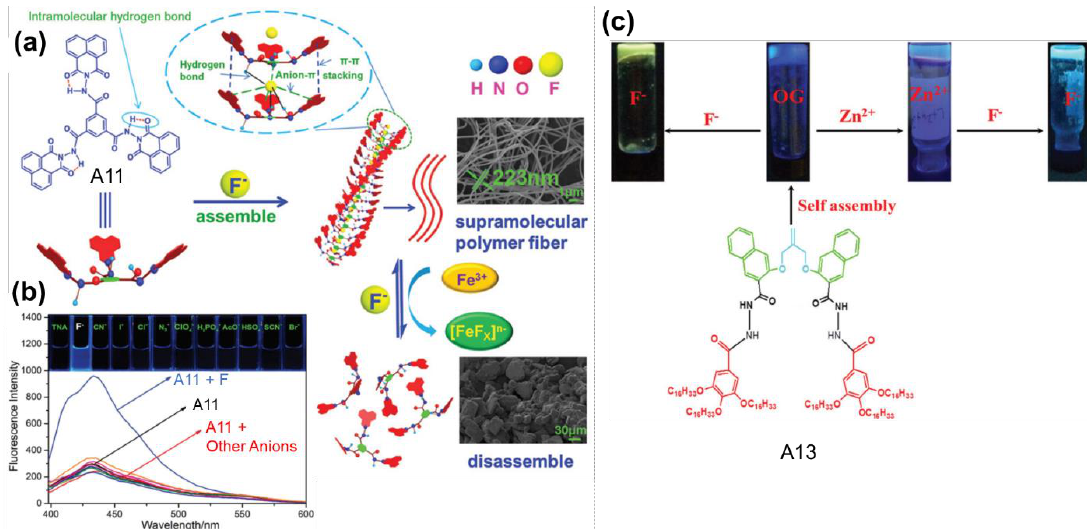
Figure 4. ( a ) Schematic representing the assembly and disassembly of A11 -fluoride supramolecular polymer. ( b ) Emission spectra and photo showing the response of A11 in the presence of fluoride and other anions. ( c ) Photos showing the emission colour of supramolecular gels formed between A13 and fluoride and Zn 2+ . Reproduced with permission from [52] and [54]. Copyright 2018 and 2016, the Royal Society of Chemistry.